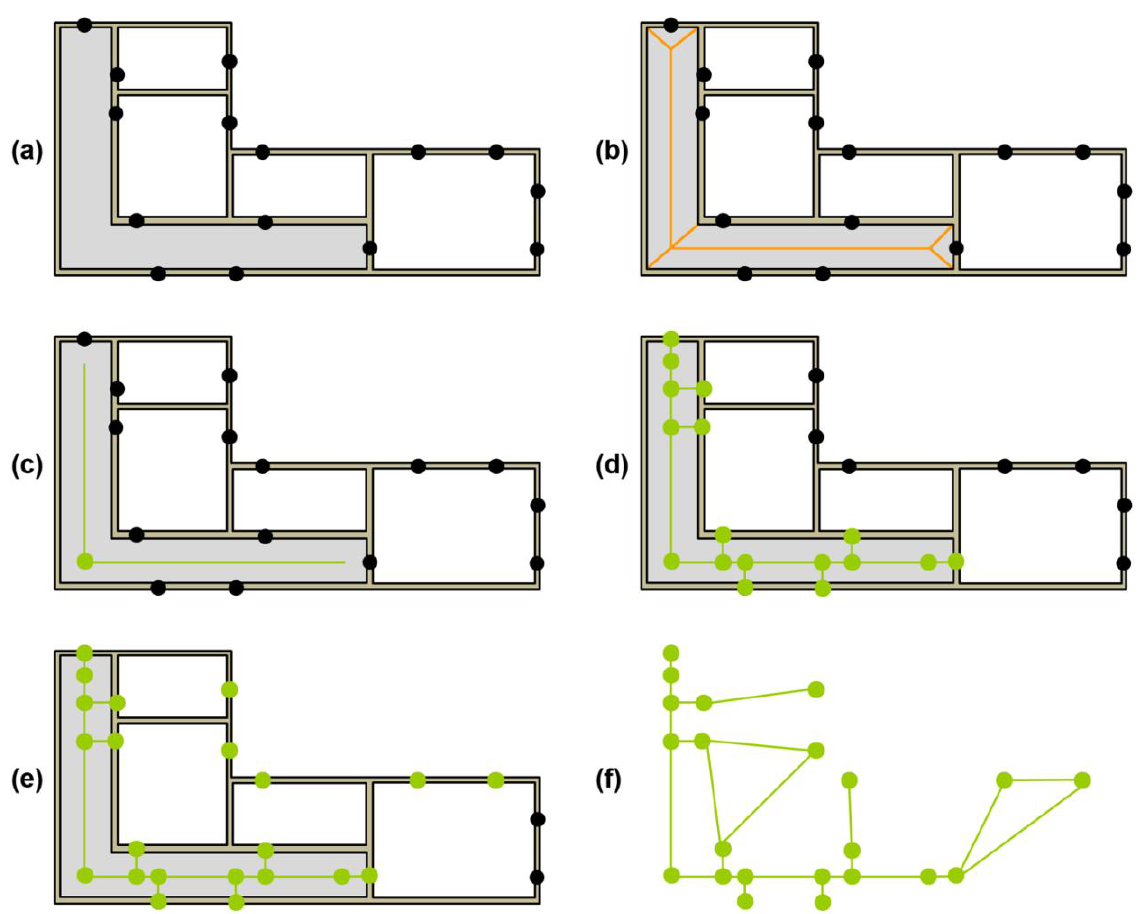
Figure 2. Stepwise generation of an indoor routing graph (according to the Weighted Indoor Routing Graph (WIRG) definition [53]) with a selection of contemplable windows for emergency evacuation